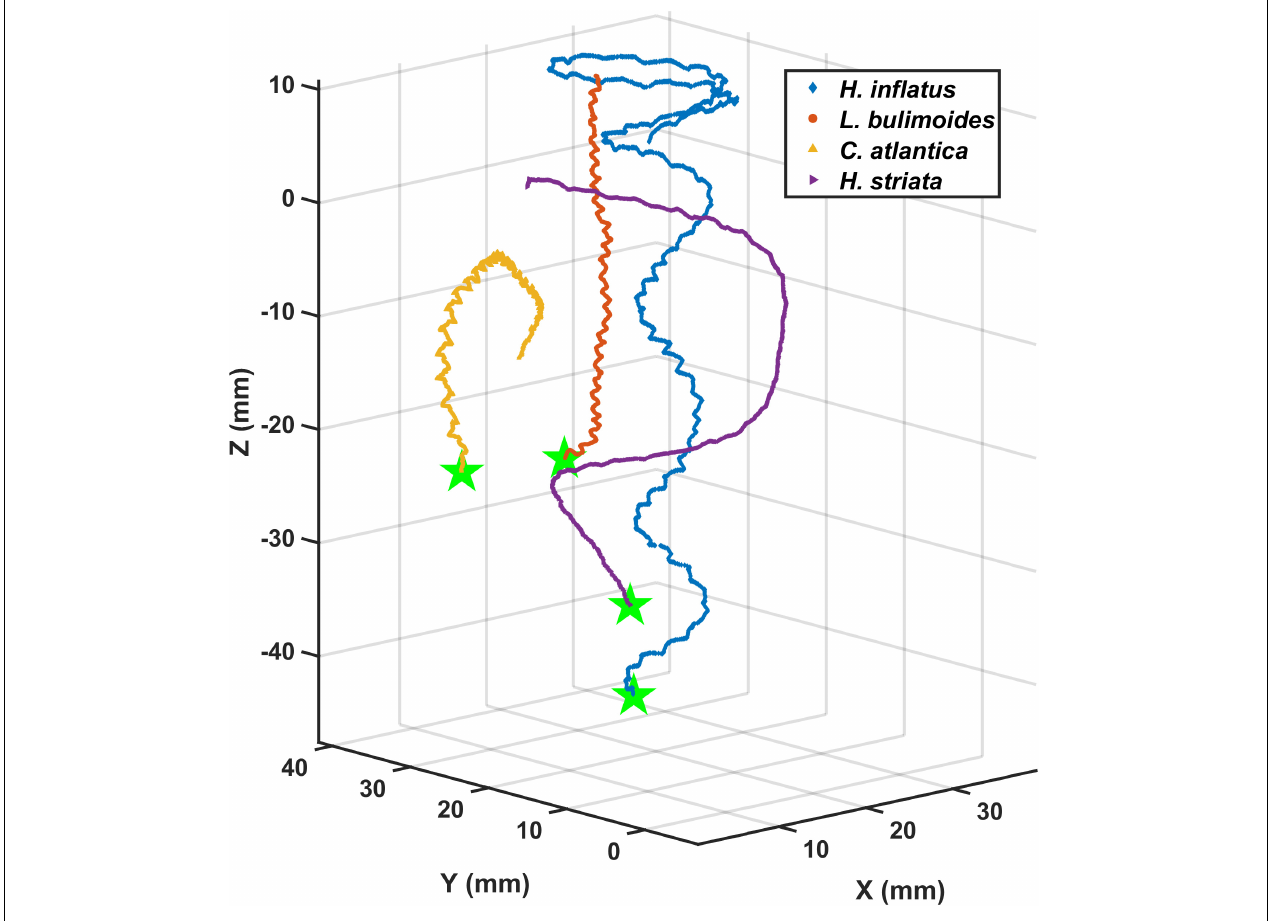
FIGURE 3 | Three-dimensional upward swimming trajectories of four thecosomatous pteropod